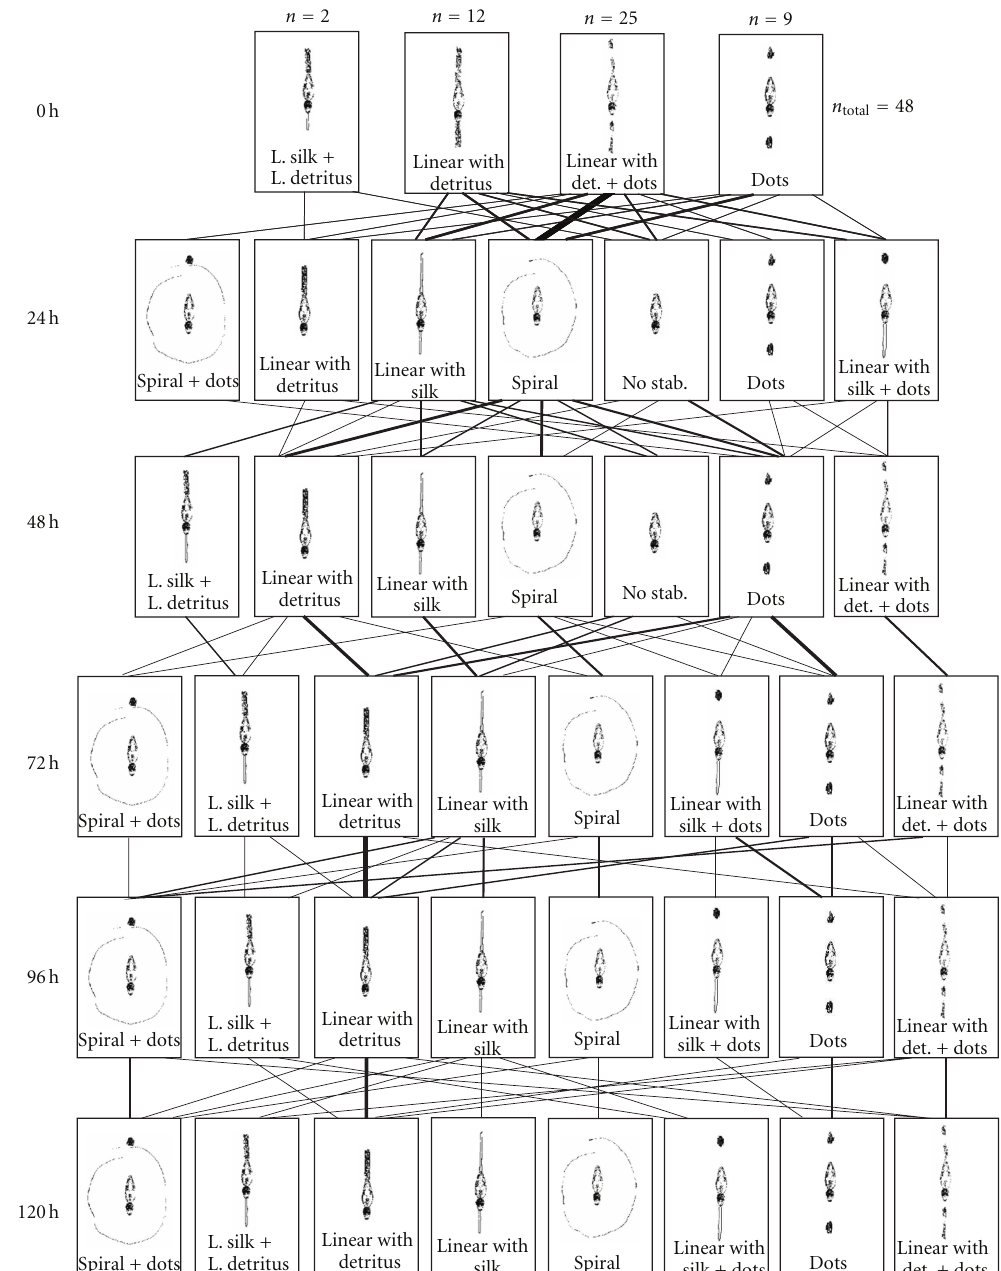
Figure 7: Reconstruction of stabilimenta by C. morretes . The thickness of the lines indicates the number of webs that passed to the next